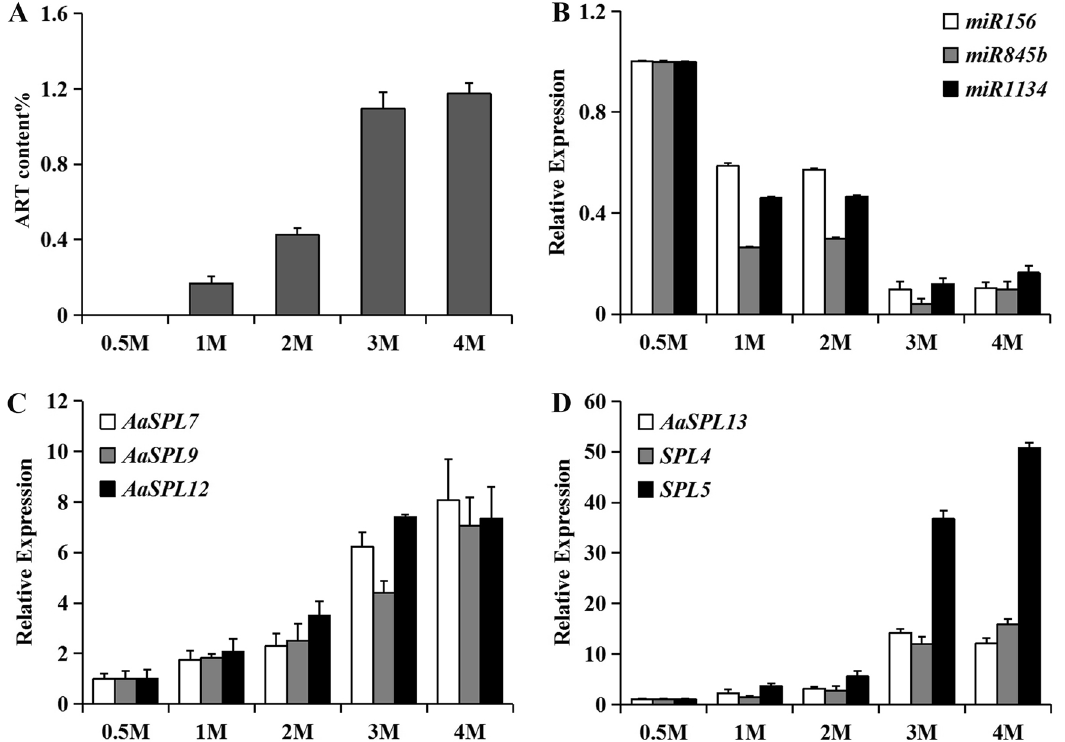
Figure 1. ART content and expression of miRNA and SPL s accumulated with age. ( A ) ART content in leaves of 0.5, 1, 2, 3 and 4-month old A. annua . The ART content was compared to the dry weight of the sample to